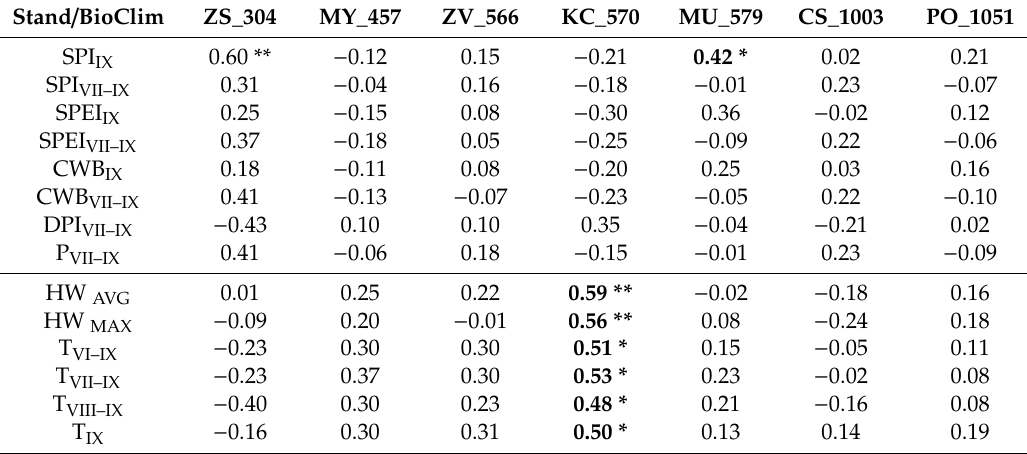
Table 10. Pearson correlation between onset of leaf colouring (LCO) and the bioclimatic indicators (BioClim) of meteorological drought: standardized precipitation indices (SPI), climate water balances (CWB), dry period index (DPI), precipitation totals (P) and heatwaves (HW), and average temperatures (T) over summer season. Significant correlations with p ≤ 0.1 (**) and p ≤ 0.5 (*) are highlighted with